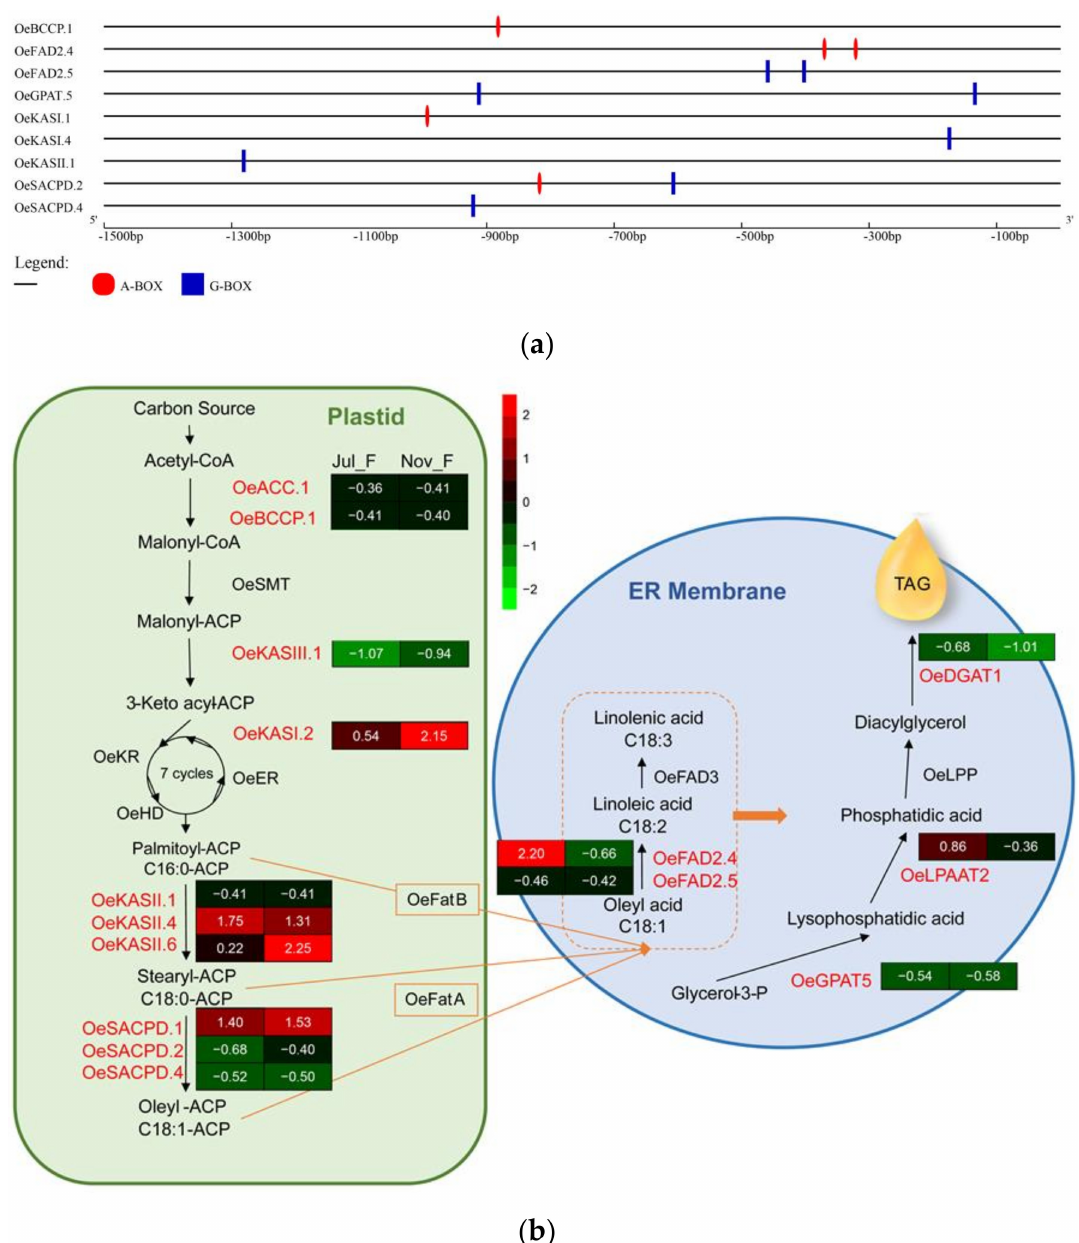
Figure 8. The prediction of upstream cis-acting elements of LPG genes and the triacylglycerol (TAG) biosynthesis pathway in olive. ( a ) The promoter sequences ( − 1500 bp) of 9 LPG genes were analyzed. The elements were identified as follows: red for the A-box element (TACGTA) and blue for the G-box (CACGTG) element. The scale at the bottom indicates the number of the nucleotides to the translation initiation codon. ( b ) Red text represents the key enzymes involved in the study, while black represents those not involved. ACC: acetyl-CoA carboxylase; BCCP: biotin carboxyl carrier protein; SMT: S-malonyl-transferase; KAS: β -ketoacyl-ACP synthase; KR: 3-ketobutyryl-ACP reductase; HD: 3-hydroxybutyril-ACP dehydratase; ER: enoyl-ACP reductase; FatA: fatty acid-ACP thioesterase A; FatB: fatty acid-ACP thioesterase B; SACPD: stearoyl-ACP desaturase; FAD: fatty-acid desaturase; GPAT: glycerol-3-phosphateacyltransferase; LPAAT: lysophosphatidate acyltransferase; LPP: phosphatidate phosphohydrolase; DGAT: diacylglycerol acyltransferase. Green indicates low expression, dark indicates intermediate expression, and red indicates high expression. The numbers in the boxes indicate normalized